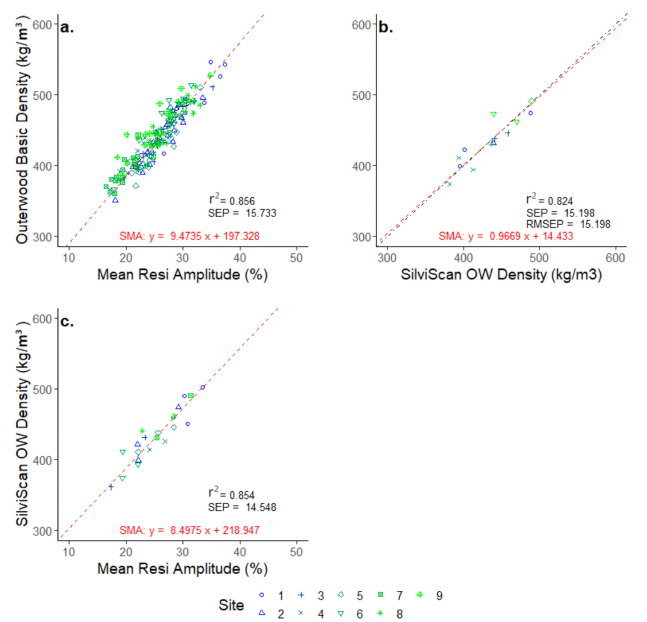
Figure 5. The correlation between outerwood core basic density and ( a ) mean outerwood Resi amplitude and ( b ) outerwood SilviScan means was strong. ( c ) Resi values were likewise strongly correlated with the SilviScan outerwood values.